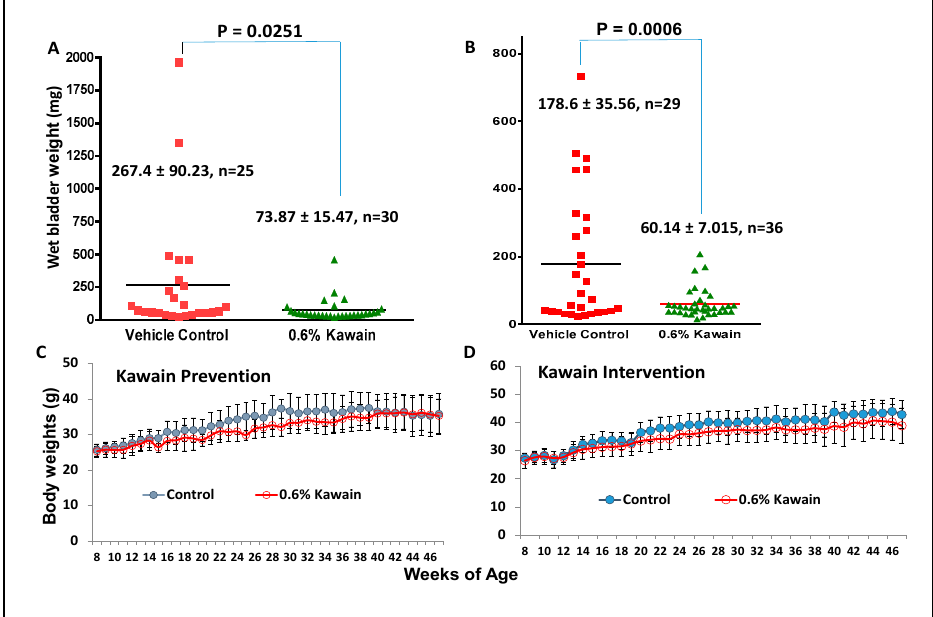
Figure 2. Dietary feeding of kawain alleviates tumor burden in the OH-BBN-induced mouse bladder carcinogenesis model. ( A , B ) The mean bladder weights of the mice treated with the control diet or 0.6% kawain diet at the end of experiments in the prevention and intervention protocols, respectively. ( C , D ) The mean body weights of the mice treated with the control diet or 0.6% kawain diet over time in the prevention and intervention protocols, respectively. Error bars are means of body weights ± standard deviations.